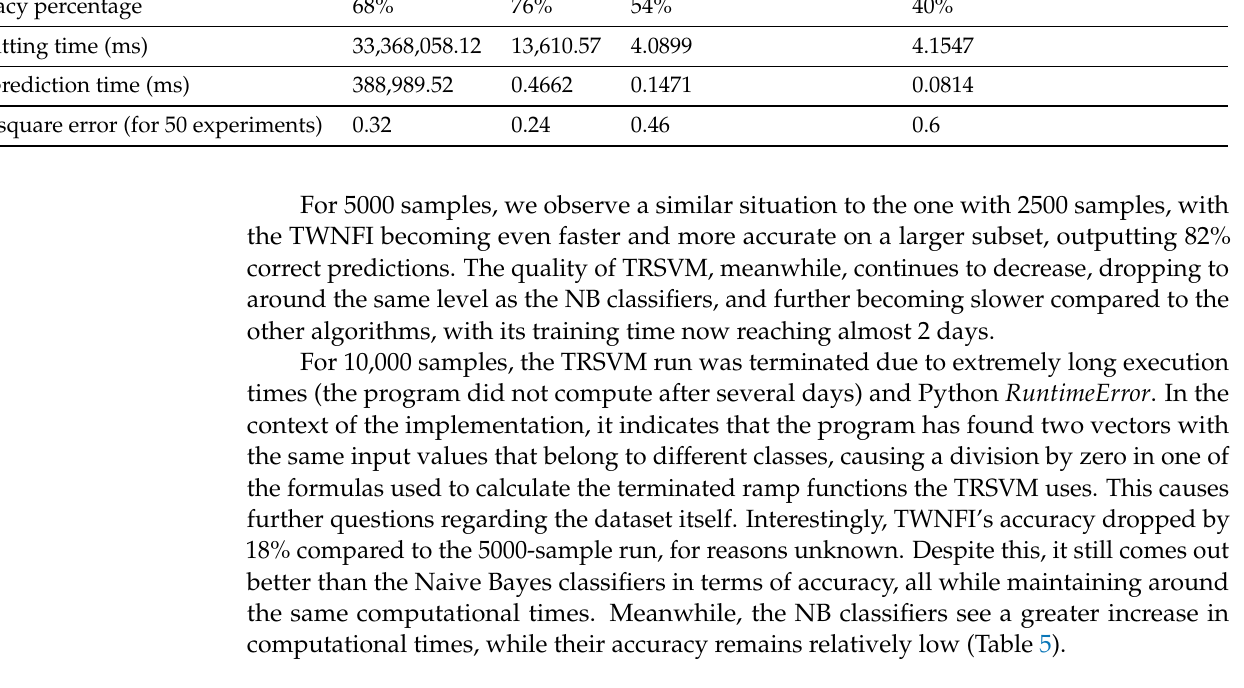
Table 5. Comparison of chosen machine learning algorithms for 10,000 samples.